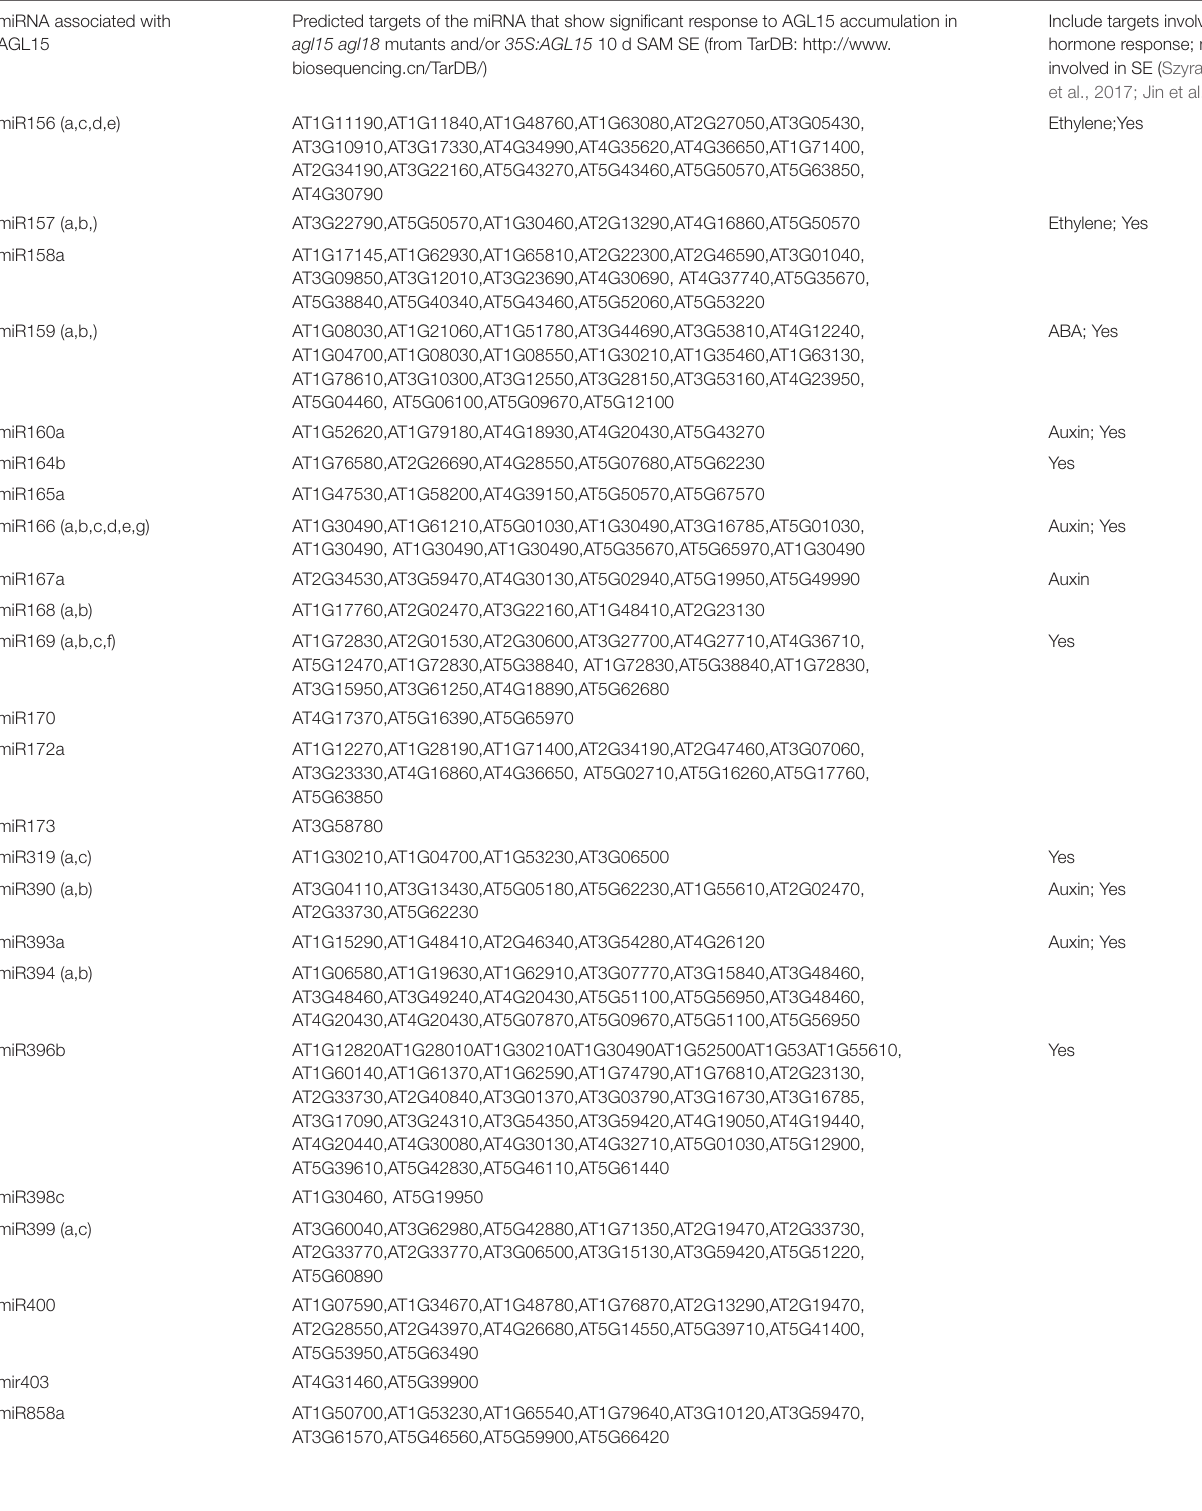
TABLE 3 | miRNAs that have associated regions bound by AGL15 (based on ChIP-chip and/or ChIP-seq). Included are predicted targets from TarDB (Liu et al., 2021) and notations of involvement in SE and/or hormone function. miRNA associated with Predicted targets of the miRNA that show significant response to AGL15 accumulation in agl15 agl18 mutants and/or 35S:AGL15 10 d SAM SE (from TarDB: http://www. AGL15